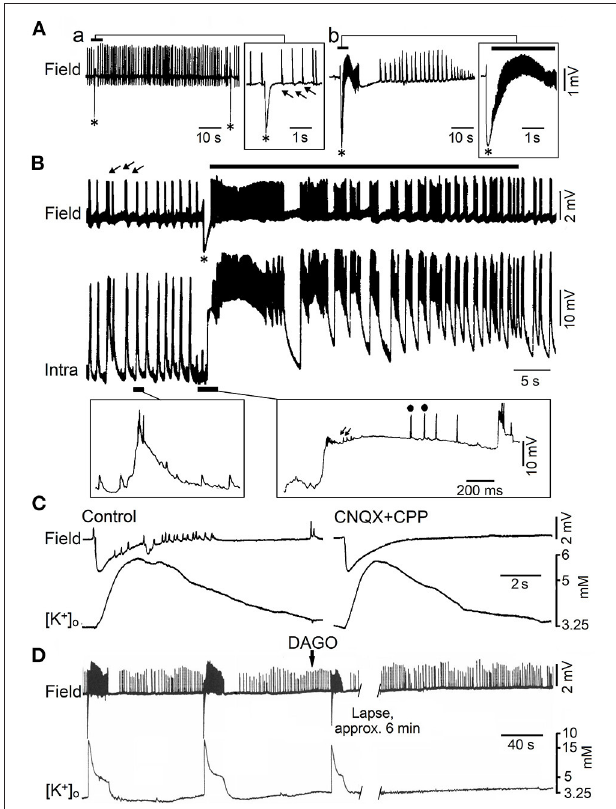
FIGURE 3 | Epileptiform activity induced by 4AP in juvenile rat hippocampal slices maintained in vitro . (A) Field potential recordings obtained during perfusion with medium containing 4AP from the CA3 subfield of adult (a) and young (14 day-old) brain slices (b). Note that only fast (arrows) and slow interictal discharges (asterisk) are recorded in adult brain slices while ictal (continuous line) and interictal epileptiform discharges occur in the young hippocampus; note also in (b) that the slow (asterisk) interictal discharge leads to the onset of a prolonged ictal event. (B) Field and intracellular (Intra) recordings obtained during perfusion with medium containing 4AP from the CA3 area of a 22-day-old rat hippocampal slice; arrows point to the fast interictal spikes while asterisk identifies the slow interictal that initiates the ictal discharge (thick line). Selected portions of the intracellular recording are illustrated at an expanded time base in the panels below; there, small arrows and dots identify depolarizing potentials and fractionated spikes, respectively. (C) Effects induced by application of non-NMDA (CNQX) and NMDA (CPP) receptor antagonists on the 4AP-induced epileptiform activity recorded with field and K + selective microelectrodes from the CA3 subfield of a 19-day-old rat hippocampal slice. Note that this pharmacological procedure blocks the fast interictal events as well as the short-lasting ictal discharge; however the elevation in extracellular [K + ] that correlates with the negative-going slow field potential is not modified. (D) Effects of the mu-opioid receptor agonist DAGO on the synchronous activity induced by 4AP in the CA3 subfield of a 15-day-old rat; note that DAGO abolishes the negative-going slow field potential along with the subsequent ictal discharge while fast interictal spikes continue to occur. [ (A) Is modified from Fueta and Avoli, 1992; (B) is modified from Avoli et al. (1993); (C,D) are modified from Avoli et al. (1996b)].